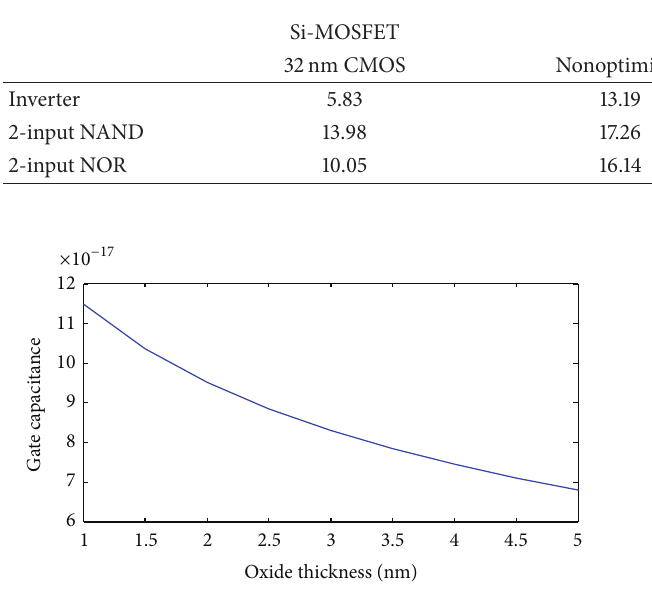
Figure 18: The average power for oxide thickness at 𝐾 ox = 25.